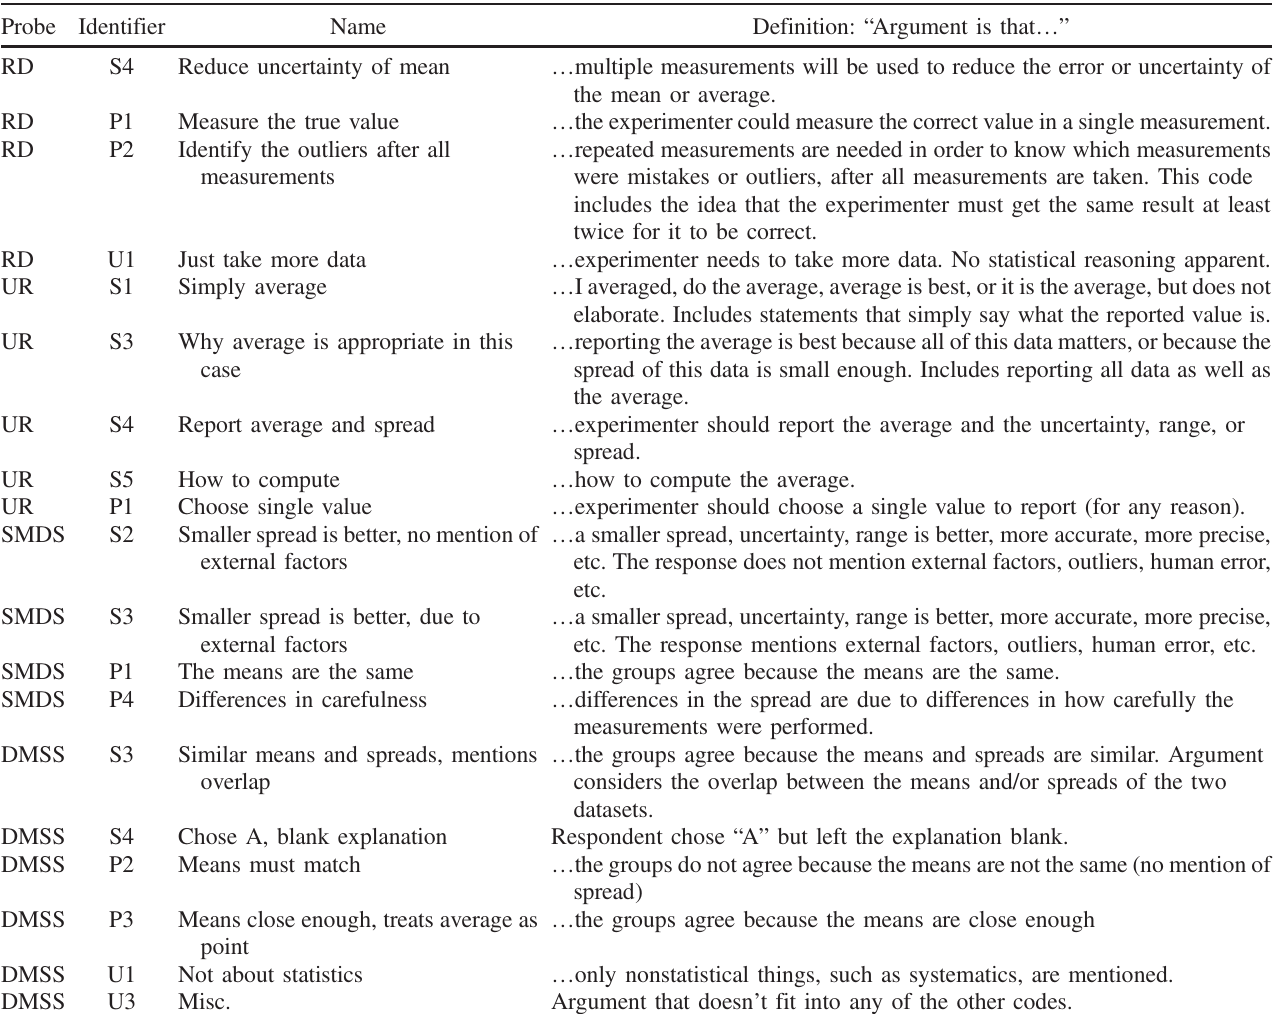
TABLE I. Selected codes from the new PMQ coding scheme. Probe